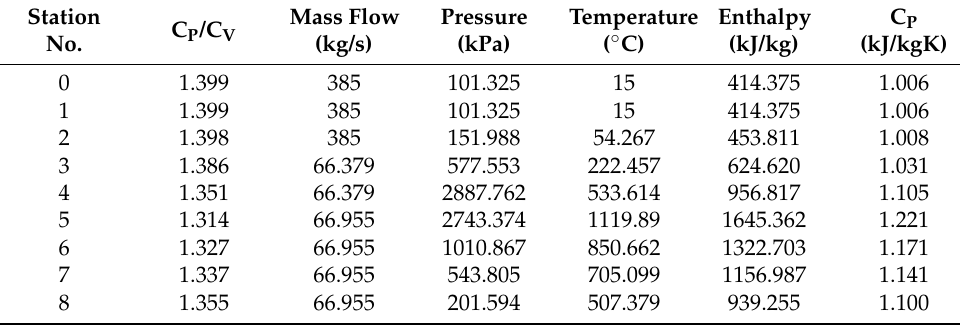
Table 3. Performance characteristics at each station for LH2 at altitude = 0 m.